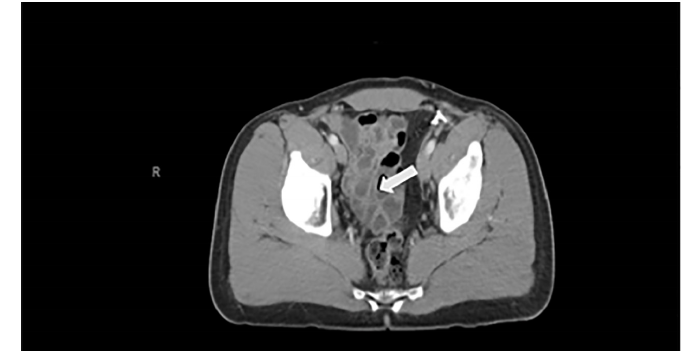
Image 2. Computed tomography abdomen and pelvis with intra- venous contrast with the arrow pointing to numerous fluid-filled, small bowel